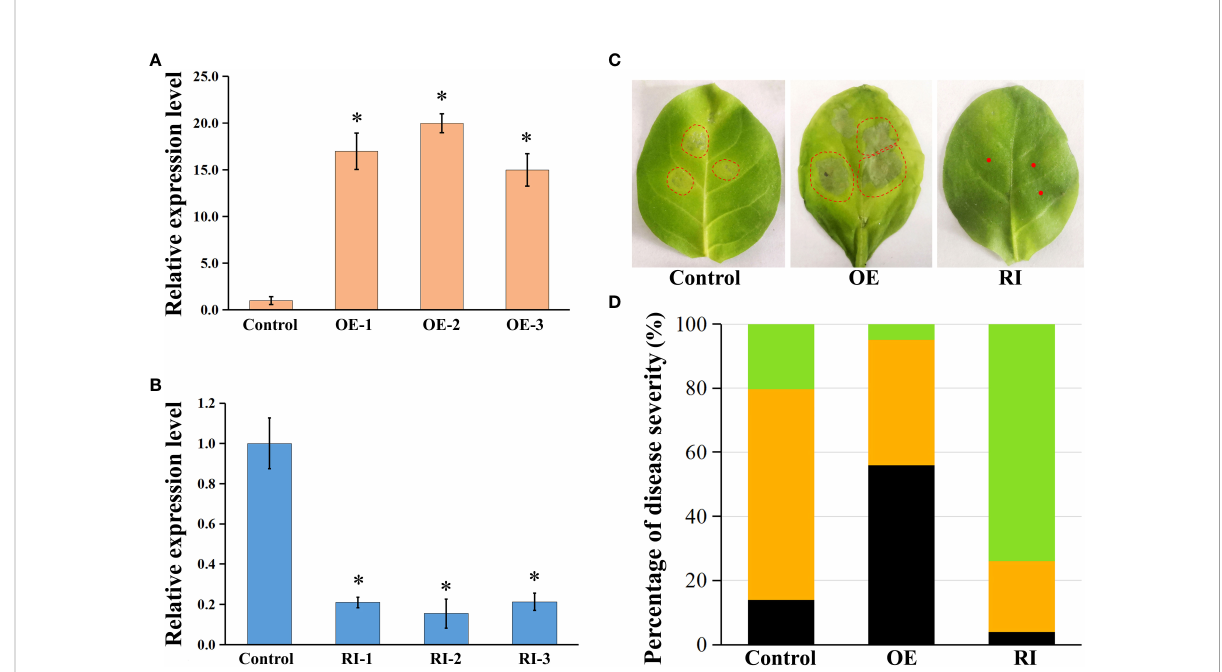
FIGURE 5 Roles of NtbHLH49 in regulating tobacco resistance to P. nicotianae . (A, B) Relative expression of NtbHLH49 in NtbHLH49 -OE and NtbHLH49 - RI plants. Tobacco Actin gene was used as an internal control. The expression level of NtbHLH49 in control plant was set as “ 1 ” . OE-1/2/3 and RI-1/2/3 indicate different transgenic lines. Data are shown as means ± SD (n = 3). Asterisks indicate signi fi cant difference from control (Student's t-test; P<0.05). (C) Representative symptoms of control, NtbHLH49 -OE and NtbHLH49 -RI tobacco leaves infected by P. nicotianae . The leaf area with visible symptom was indicated with dashed-circle. (D) Percentiles of control, NtbHLH49 -OE and NtbHLH49 -RI tobacco leaves with differential symptom severity. The black color indicates water-soaking symptom, the orange color indicates necrosis symptom, and the green color indicates no visible